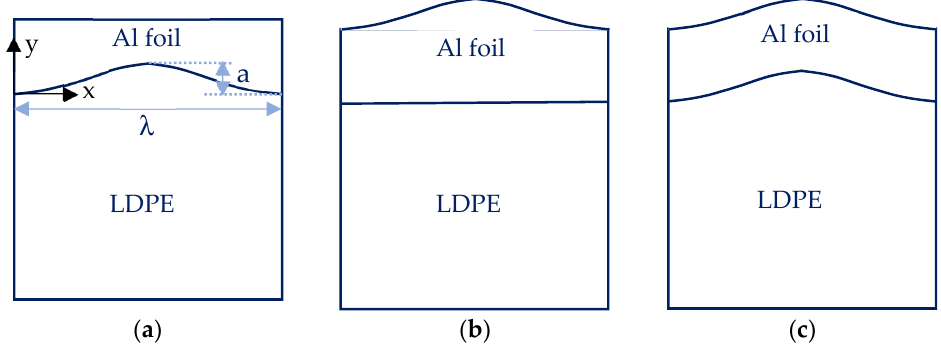
Figure 4. Polymer-supported Al film with an idealized sinusoidal interface: ( a ) wavy LDPE surface with flat Al surface; ( b ) wavy both Al and LDPE surface and ( c ) wavy Al surface with a flat LDPE surface.